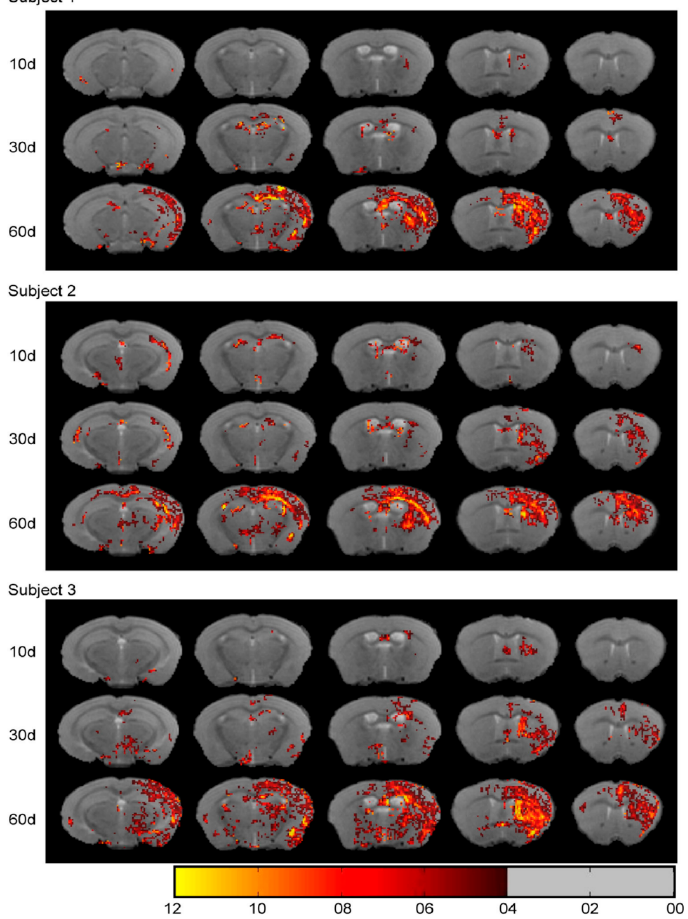
Figure 4. After different times (10 days, 30 days, or 60 days) of the rAAV2-retro–CAG–Ferritin injection, the CPU connection area is displayed by MRI in vivo (expressed by the change in T2 relaxation times). A color change (red–yellow) is used to indicate a change in T2 relaxation time (4–12 ms). Reproduced with permission from Ref. [33], 2021, Wiley.